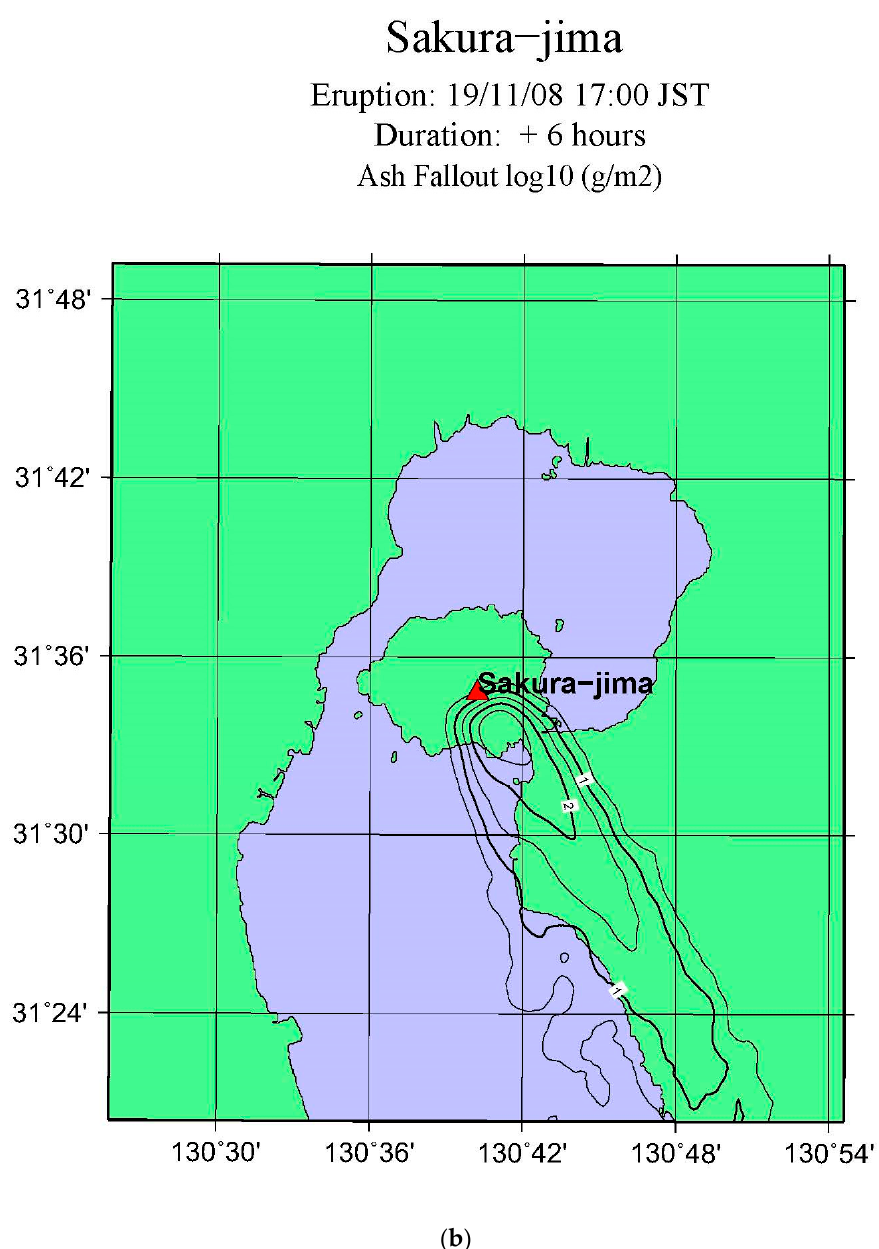
Figure 10. Particle distribution of ash fallout as in Figure 5 ( a , b ), but using the MP radar data.